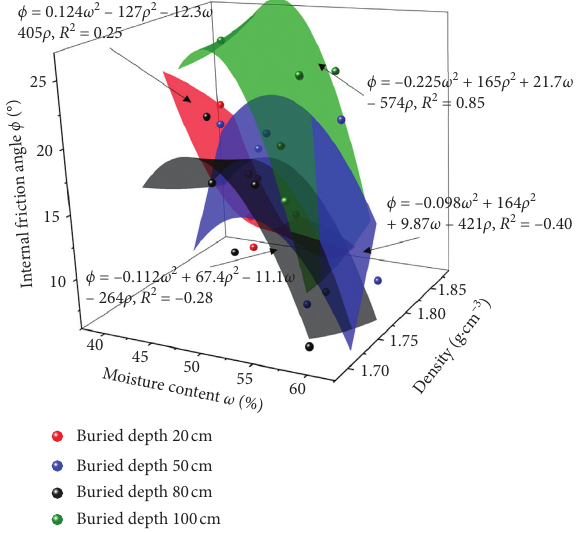
Figure 11: Relationship between internal friction angle and density and water content in different down along other vertical cracks of the slope shoulder to form a new gully. At the same time, the soil blocks and soil striped with the word “eight” on the slope surface fall off and collapse locally due to rain erosion. (f) The collapse stage of the slope toe (Figure 13(f)): because all the rainwater of the slope is collected to the toe of the slope, the runoff of the toe increases, the moisture content of the soil at the toe